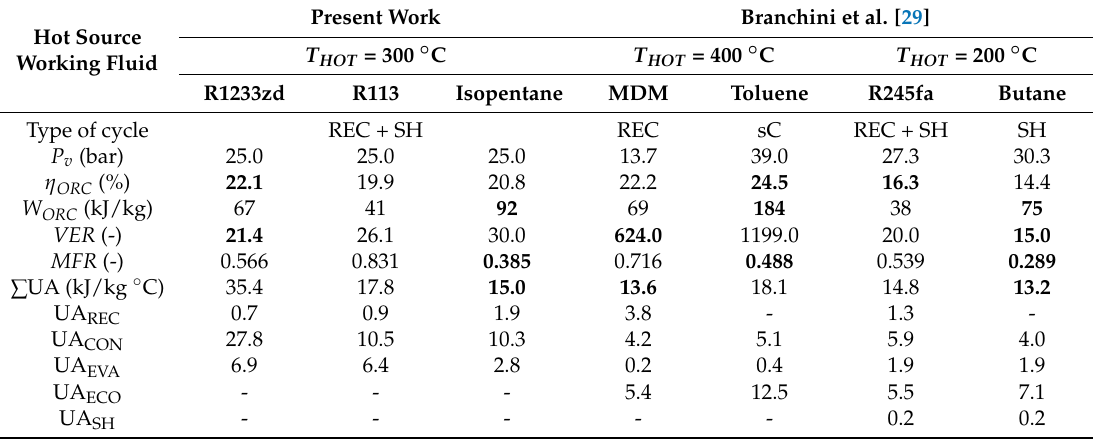
Table 8. Analyses and comparison of the ORC performance